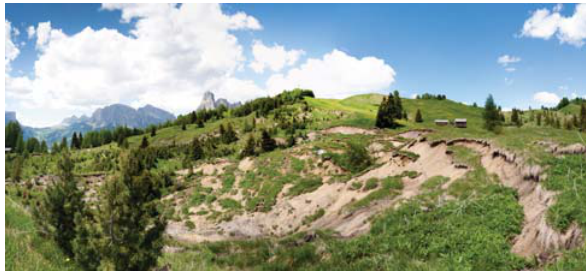
Figure 2. Photo of the area of interest (I-AOI) showing morphological features of the